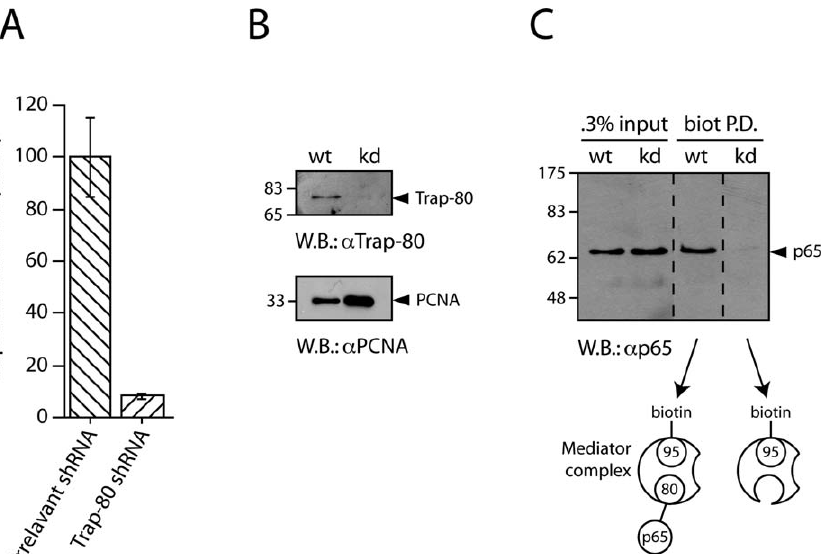
Figure 1. Removal of Trap-80 Disrupts the Interaction of p65 with Mediator (A) Knock-down of Trap-80 mRNA by RNA interference. Expression level of Trap-80 mRNA in 3T3 fibroblasts expressing an shRNA targeting Trap-80, shown as a percentage of the level in control cells (expressing an irrelevant shRNA, hereafter referred to as wild type). mRNA levels were measured by quantitative PCR and normalized with respect to Tbp . Error bars indicate standard errors; the results presented here are representative of more than ten experiments. (B) Knock-down of Trap-80 protein levels. Nuclear extracts were prepared from wild-type (wt) or Trap-80 knock-down (kd) fibroblasts, and endogenous Trap-80 (upper panel) or PCNA (as a loading control, lower panel) was detected by western blotting. (C) Co-precipitation of p65 and Trap-95 depends on the presence of Trap-80. Wild-type and Trap-80 knock-down fibroblasts were simultaneously transduced with retroviruses expressing biotin-tagged Trap-95 and the BirA biotin ligase, and nuclear extracts were prepared after stimulation with TNF- a . The Mediator complex, containing biotinylated Trap-95, was pulled down using streptavidin beads (biot P.D.), and any associated p65 was detected by western blotting. Pull-down using in vivo biotinylation is our method of choice for analysis of proteins bound to the endogenous Mediator complex, due to the extremely high affinity of the streptavidin-biotin interaction. The levels of biotin-tagged Trap-95 were similar in both cell types, as measured by the level of co-expressed Tomato fluorescent protein (Figure S3). Dotted lines indicate where nonrelevant lanes have been cropped from the figure.